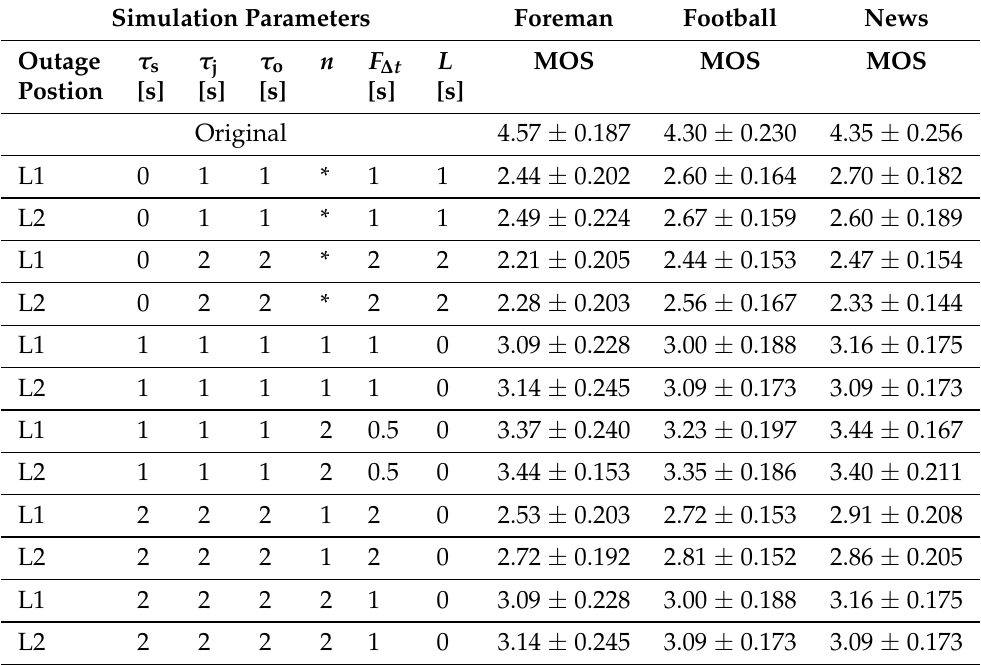
Figure 10. MOS with 95% confidence intervals of the “News” video with two outage locations for τ j = 2 and τ o = 2. Table 4. Simulation details and MOS for various videos (with * denoting